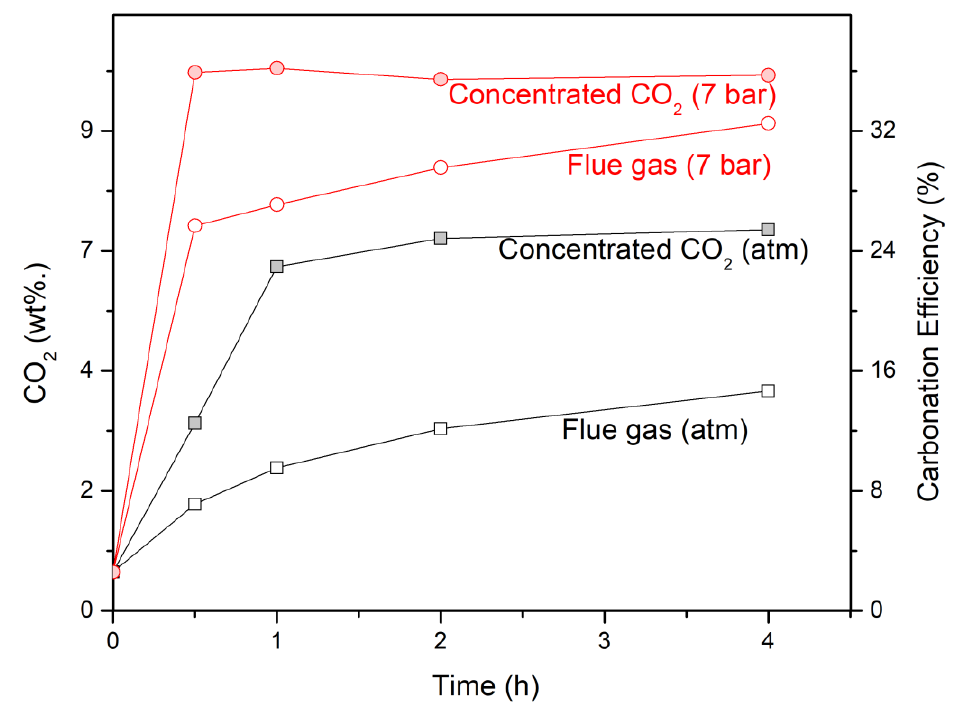
Figure 5. Carbonation efficiency (%) and CO 2 uptake (wt%) of the samples, calculated on the basis of TPD analysis for samples treated under conditions of different pressures, times of reaction and CO 2 concentrations.